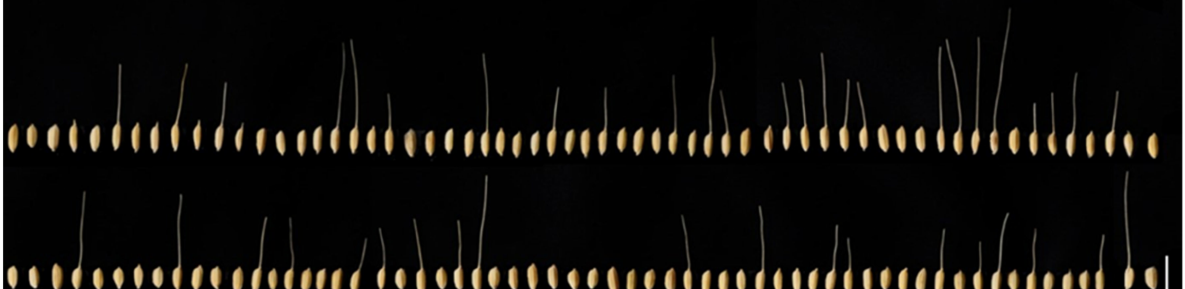
Figure 1. Phenotype of various awn lengths in the CNDH population. O. sativa spp. indica cv. Cheongcheong and O. sativa spp. japonica cv. Nagdong were crossed to obtain F 1 . F 1 was another cultured to create a 120 CNDH population. Due to the indica type, Cheongcheong, the presence or absence of awn in the 120 CNDH population was very diverse. Bars, 10 mm.